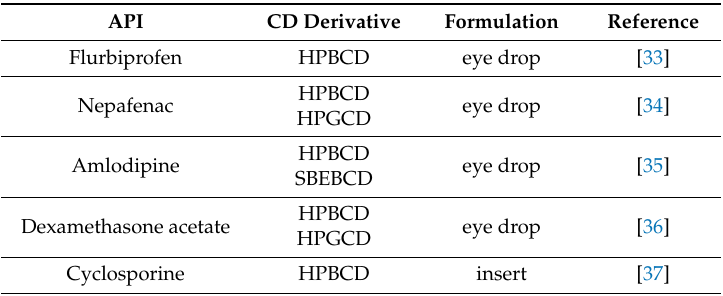
Table 2. Recent approaches to use CDs in ophthalmic formulations.